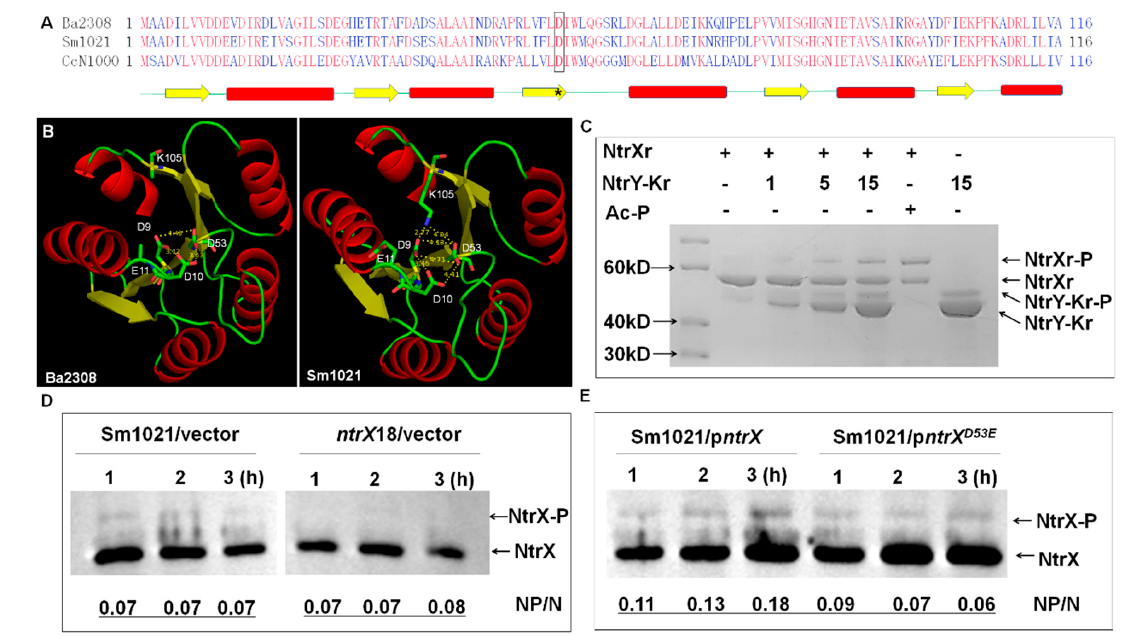
Figure 4. Phosphorylation of the 53rd aspartate residue in the NtrX protein. ( A ) Alignment of NtrX receiver domain from three bacterial species. The amino acid sequence of each protein was obtained from NCBI. Secondary structures of the receiver domain are shown as green lines (loops), yellow arrows ( β -sheets), and red bars ( α -helixes). Both the aspartate residue in the box and the asterisk represent the predicted phosphorylation site from Pfam. Ba2308, B. abortus bv. 1 str. 2308; Sm1021, S. meliloti 1021; CcN1000, C. crescentus N1000. ( B ) 3D structure of the NtrX receiver domain of S. meliloti NtrX. It was reconstructed using B. abortus homolog protein (PDB: 4d6y) as a template in Swiss-Model. Possible electrostatic interactions associated with the 53rd aspartate residue are labeled via Pymol. ( C ) In vitro NtrX phosphorylation catalyzed by the NtrY kinase domain. NtrY-Kr, His-NtrY kinase domain fusion protein (1, 3 and 10 µ g); NtrXr-P, phosphorylated NtrXr (10 µ g); Ac-Pi, acetyl phosphate (2 mM). ( D , E ) In vivo phosphorylation of S. meliloti NtrX. Phosphorylated NtrX proteins from S. meliloti cells were separated by Phos-Tag gel and detected by Western blotting of anti-NtrX polyclonal antibodies. S. meliloti 1021 cells carrying p ntrX or p ntrX D53E were grown in LB/MC broth with 1 mM IPTG for 1 to 3 h. Then, ~1 µ g of total protein was loaded into each well. NP/N is the intensity of phosphorylated proteins divided the intensity of non-phosphorylated proteins. The intensity data were collected using Image J